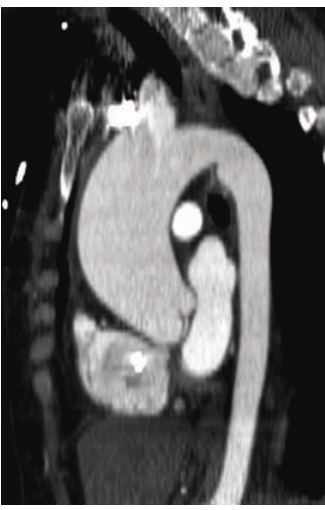
Figure 5: Fusiform ascending aortic aneurysm—sagittal recon- structed CT image in a 47-year-old male shows a smooth, fusiform aneurysm of the ascending aorta, which tapers to normal caliber at the proximal